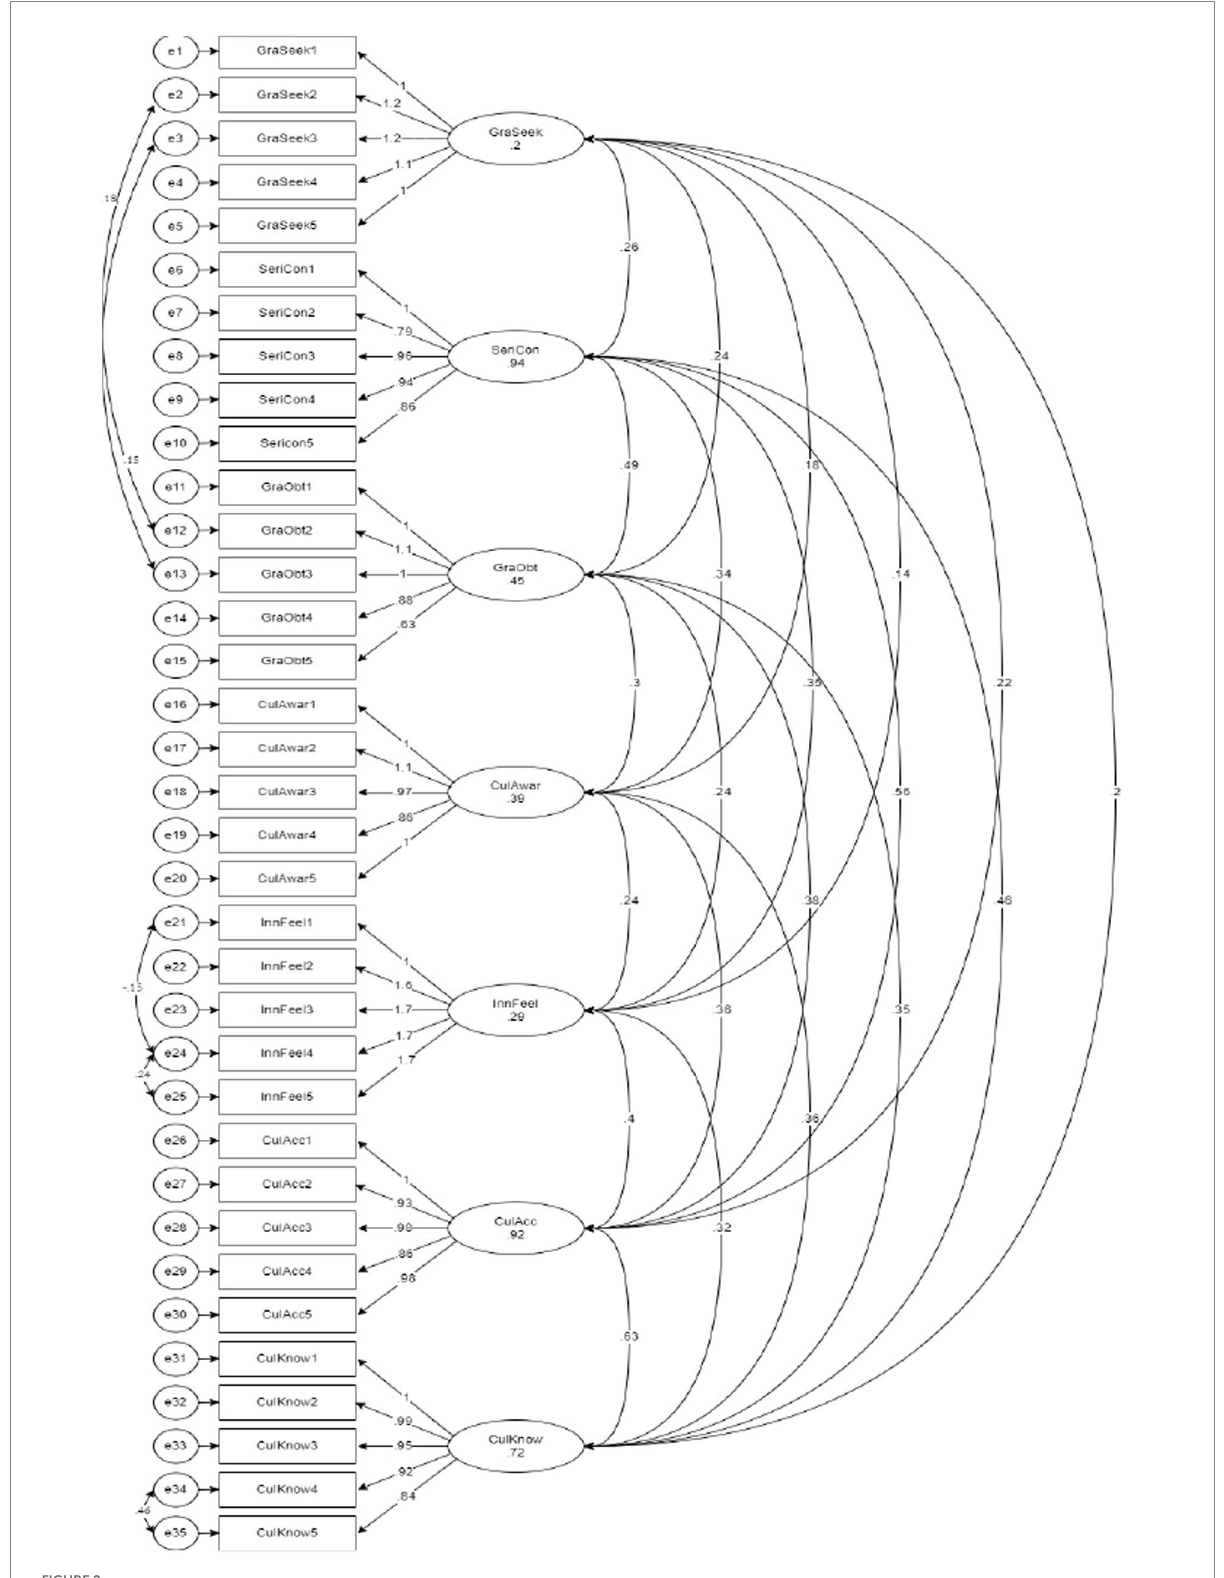
FIGURE 2 Confirmatory factor